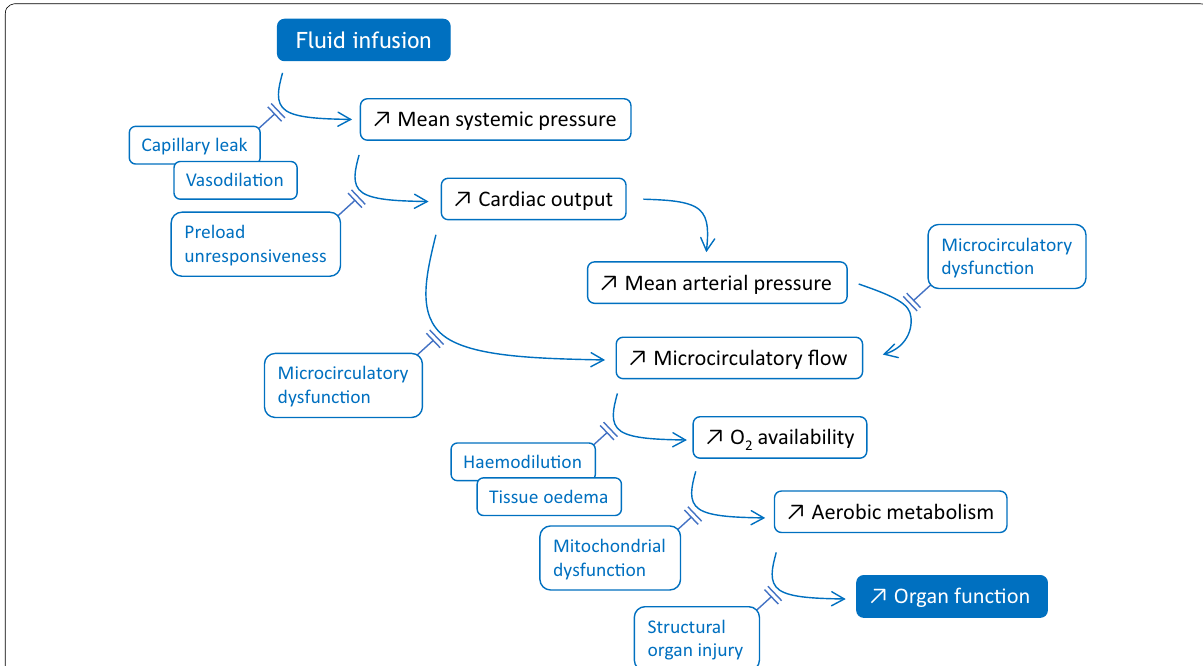
Fig. 1 Schematic pathway through which fluid administration leads to organ function improvement, and the issues that may interrupt